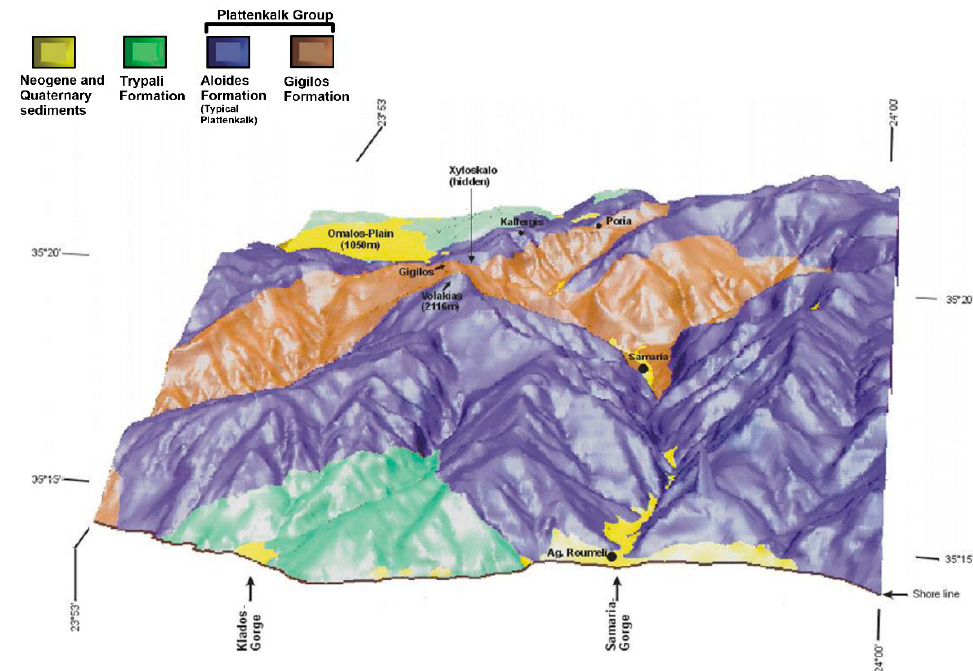
Figure 6. The 3rd geological model for the wider region of Samaria Gorge (modified from Manutsoglu et al., 1999; 2001 [6,7]). Table 1. Correlation of the proposed geological models for the wider Samaria Gorge area. 2nd Model (by Pavlaki and 3rd Model (by Perleros [5]) Manutsoglu et al.